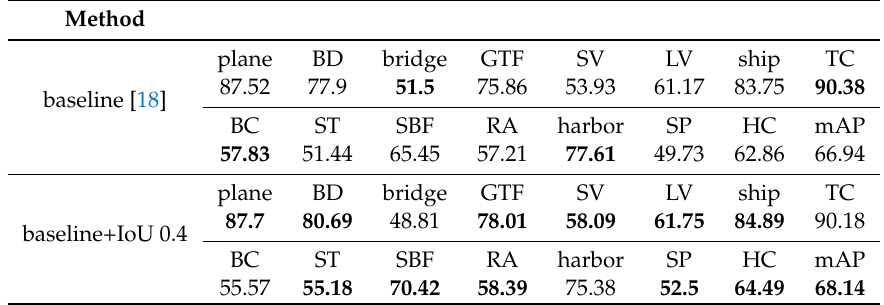
Table 4. The effect of setting different IoU thresholds for the detector during training. We perform evaluation on the val_clip set The best results on each category is highlight in